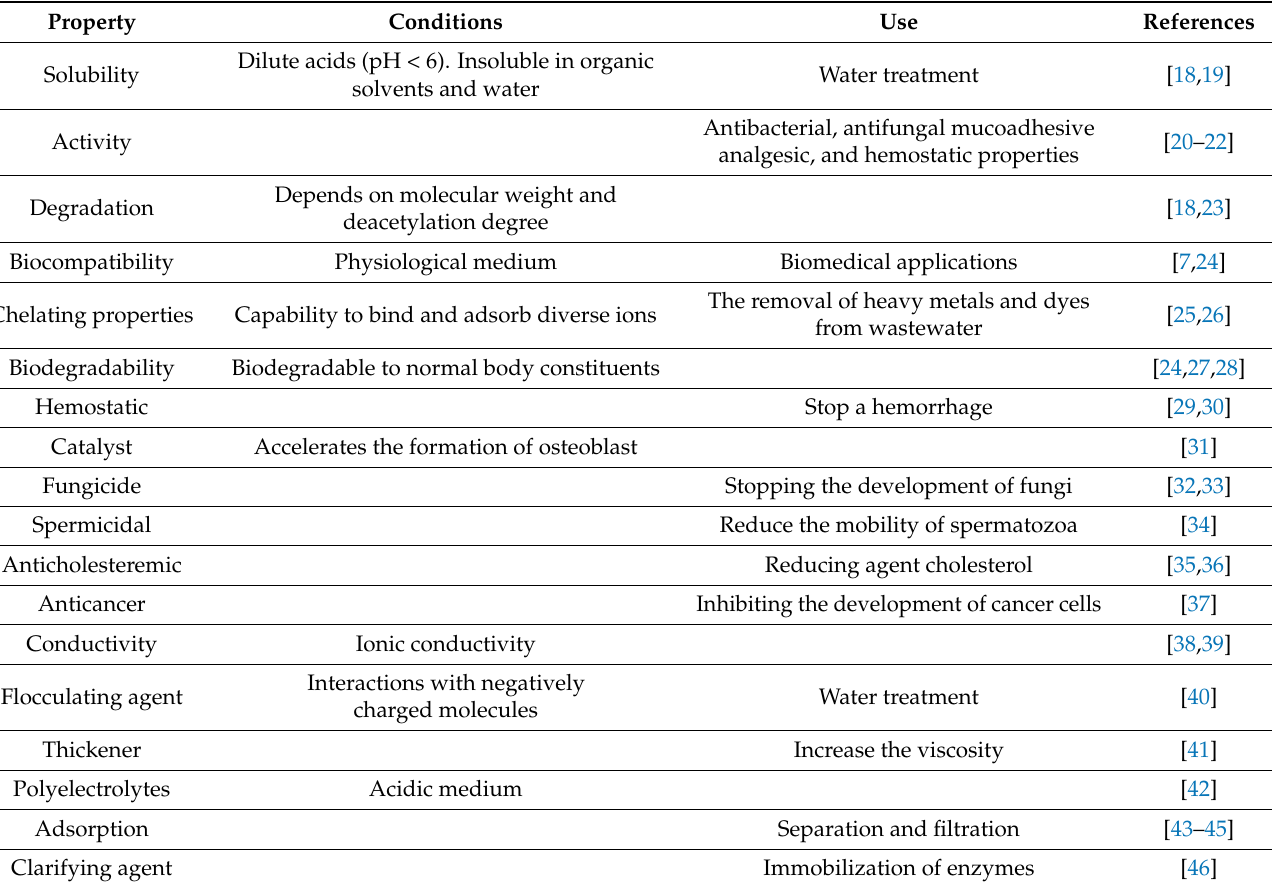
Table 2. General properties of chitosan